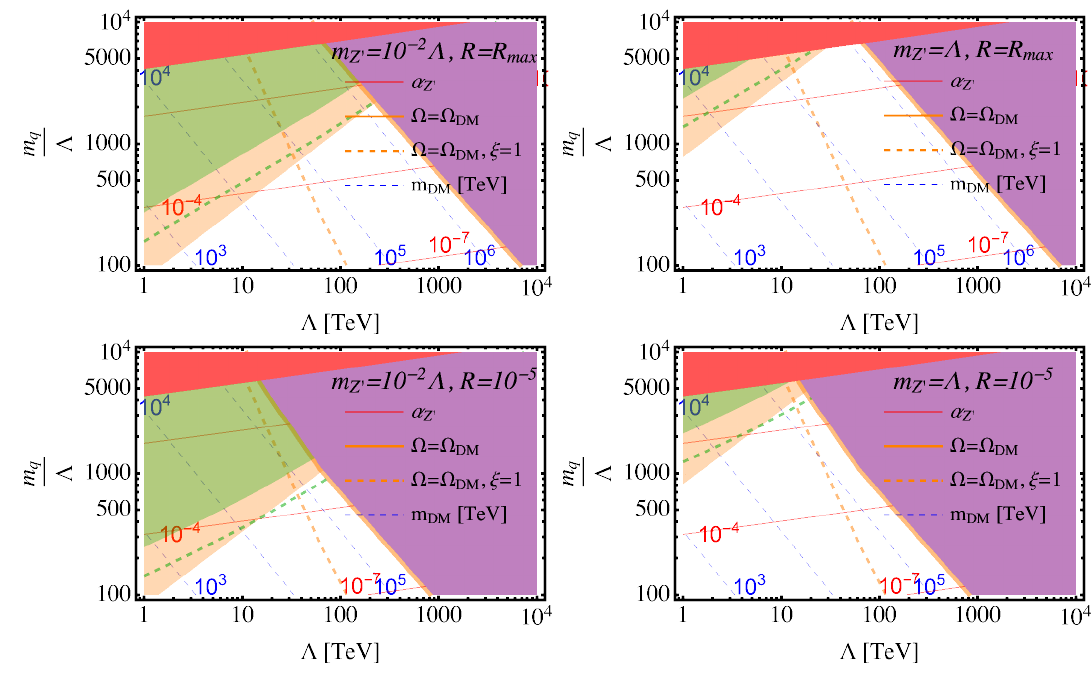
Figure 7 . The relic abundance line (solid orange), and constraints from direct detection (green) and collider (orange) searches on the parameter space of our model for different values of m Z 0 and R . For any point below the dashed green line the scattering rate at the direct detection experiments will be below the neutrino floor. Contours of constant DM mass are denoted by dashed blue lines. In each plot the purple region corresponds to where the universe is overclosed. The relic abundance line when the glueball decay is neglected is denoted by the dashed orange line. We set α Z 0 (red lines) to the value that minimizes Γ as allowed by the BBN bounds (similar to figure 6). The red region √ is ruled out since the required α Z 0 there exceeds 4 π and so we expect perturbatively calculated rates to break down. Depending on the Z 0 mass, bounds on the model can change significantly. The value of R can substantially affect the final relic abundance line location; for lower values of R the relic abundance line approaches the dashed orange line. While a large part of the parameter space is already ruled out, viable parameter space still